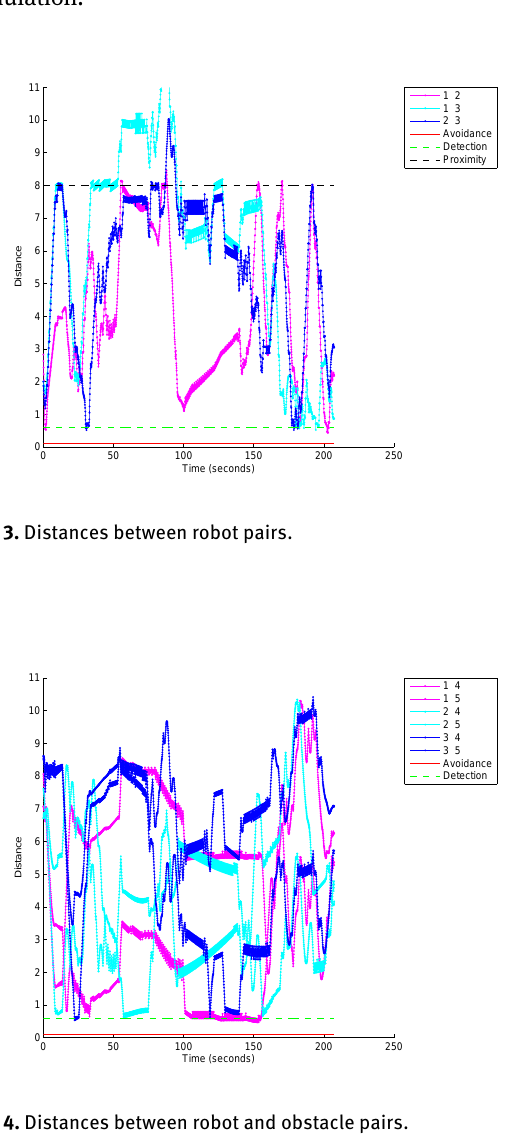
Fig. 4. Distances between robot and obstacle